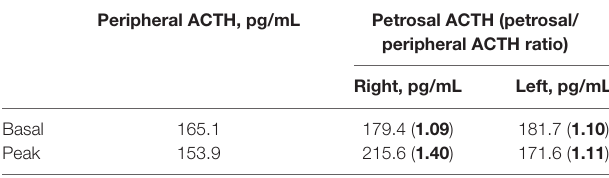
ACTH, adrenocorticotropic hormone; CRH, corticotropin-releasing hormone.